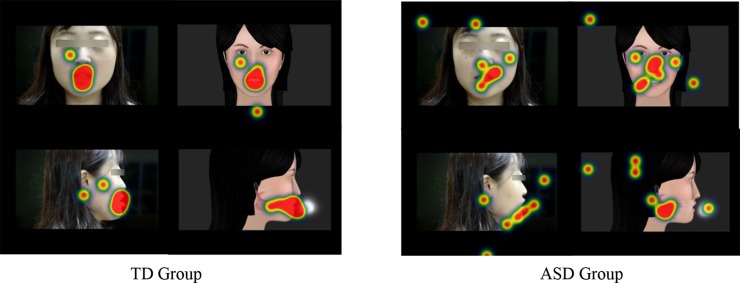
Heat maps of one testing syllable in Experiment 1.